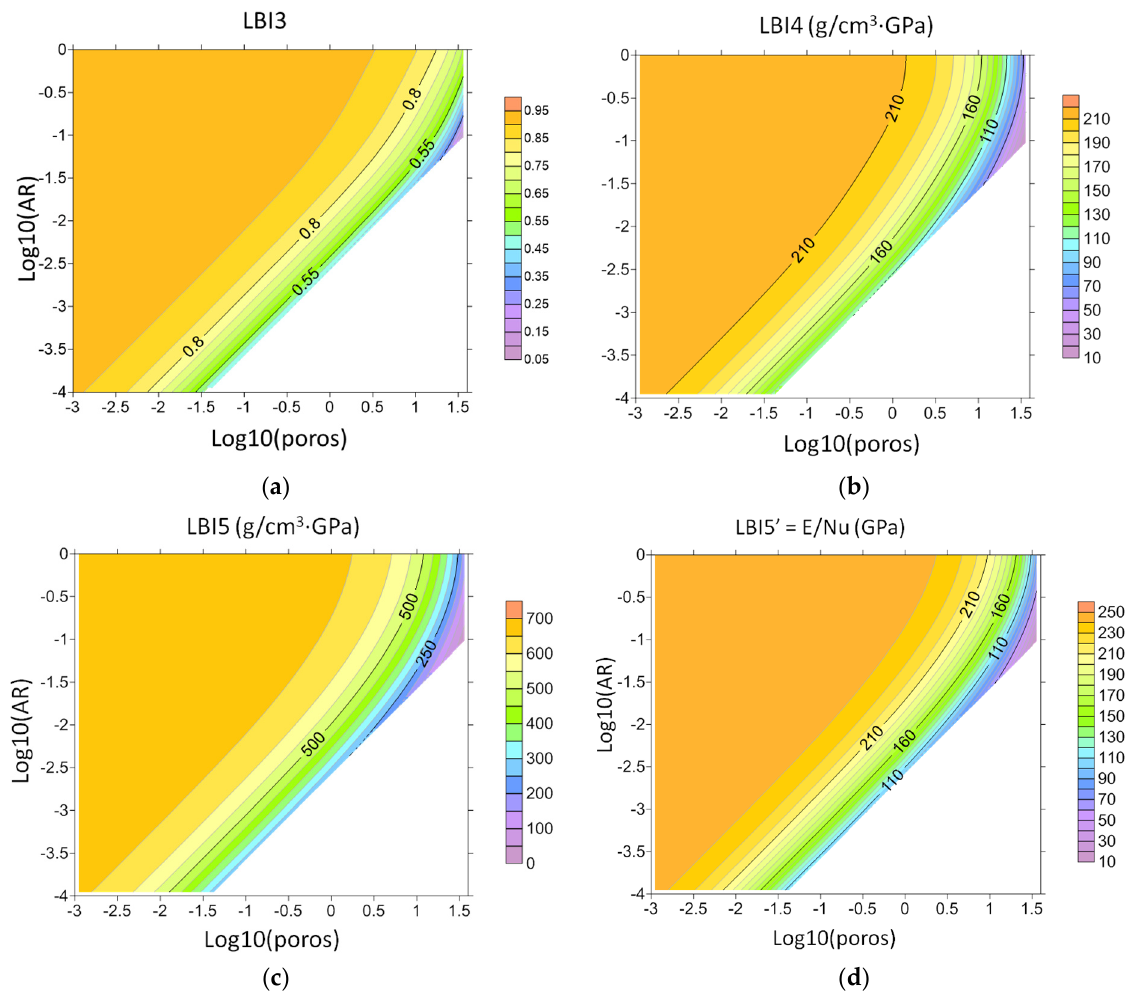
Figure 7. Brittleness indices ( a ) LBI 3 , ( b ) LBI 4 , ( c ) LBI 5 , and ( d ) LBI 5 ′ for a model of carbonate matrix with randomly oriented brine-saturated voids versus decimal logarithms of porosity and void’s aspect ratio.